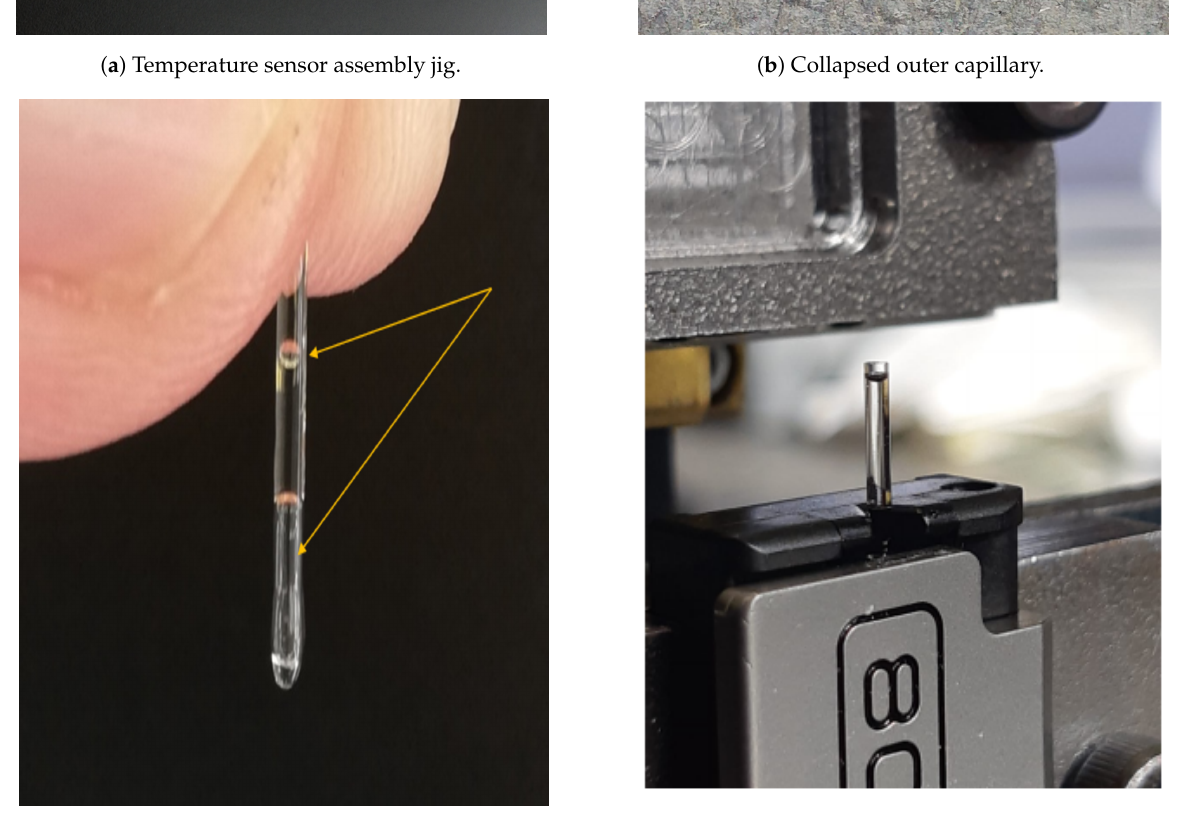
Figure 8. ( a ) Temperature sensor assembly rig; ( b ) Outer capillary with collapsed end face (circled); ( c ) Oil filled outer capillary with macro-bubbles present; ( d ) Degassed outer